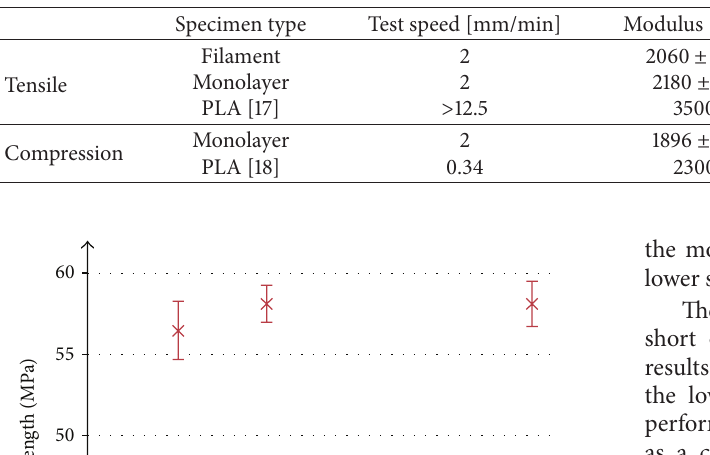
Table 1: Strength and modulus comparison.